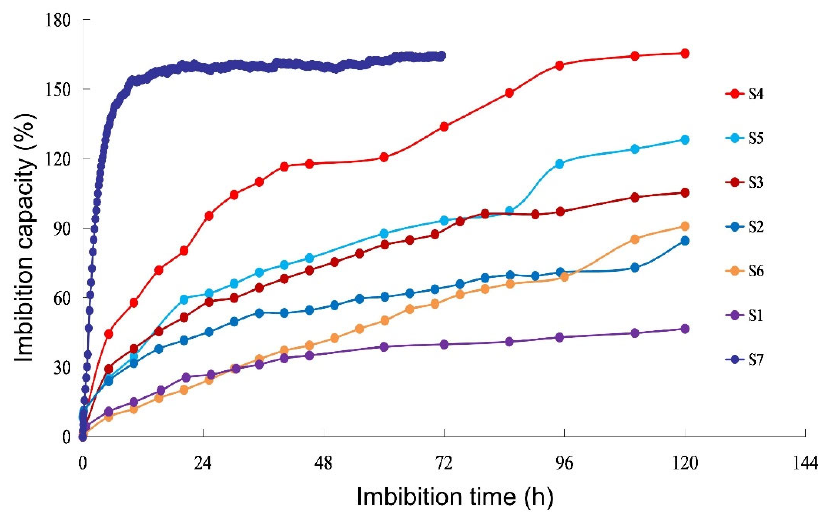
Figure 7. Curves of forcible imbibition capacity over imbibition time of the 7 shale samples.